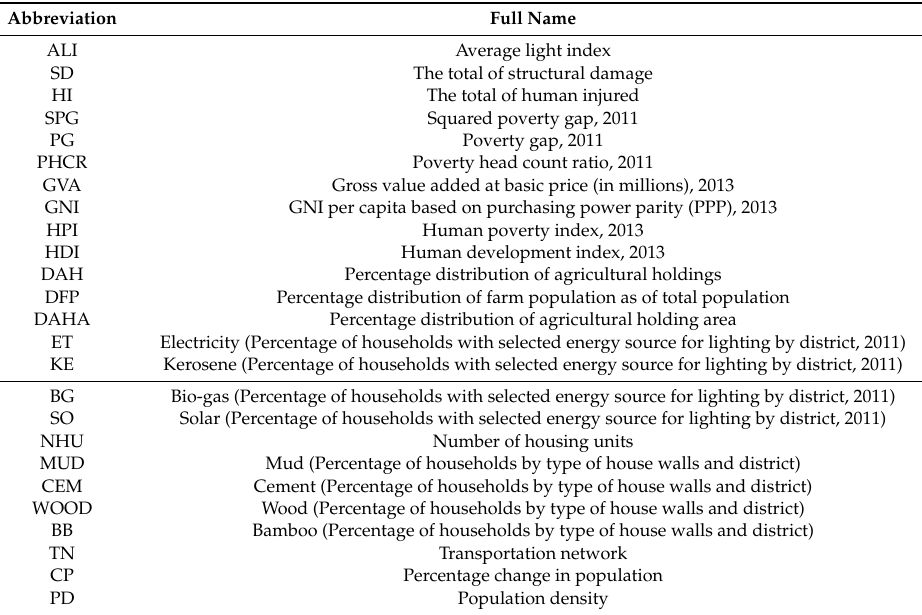
Table A1. The implications of socio-economic